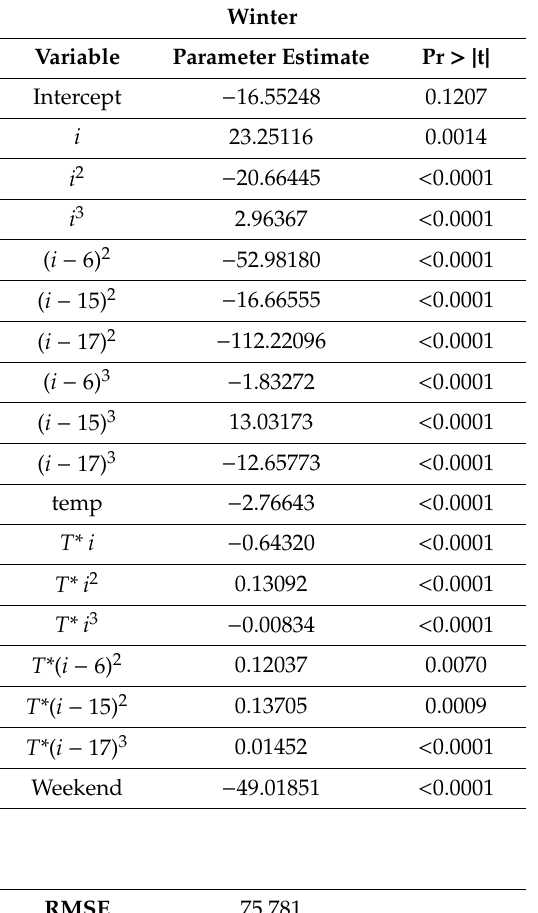
Table A6. The Results for the Regression Model for the Winter and Spring Seasons (Model 2). Winter